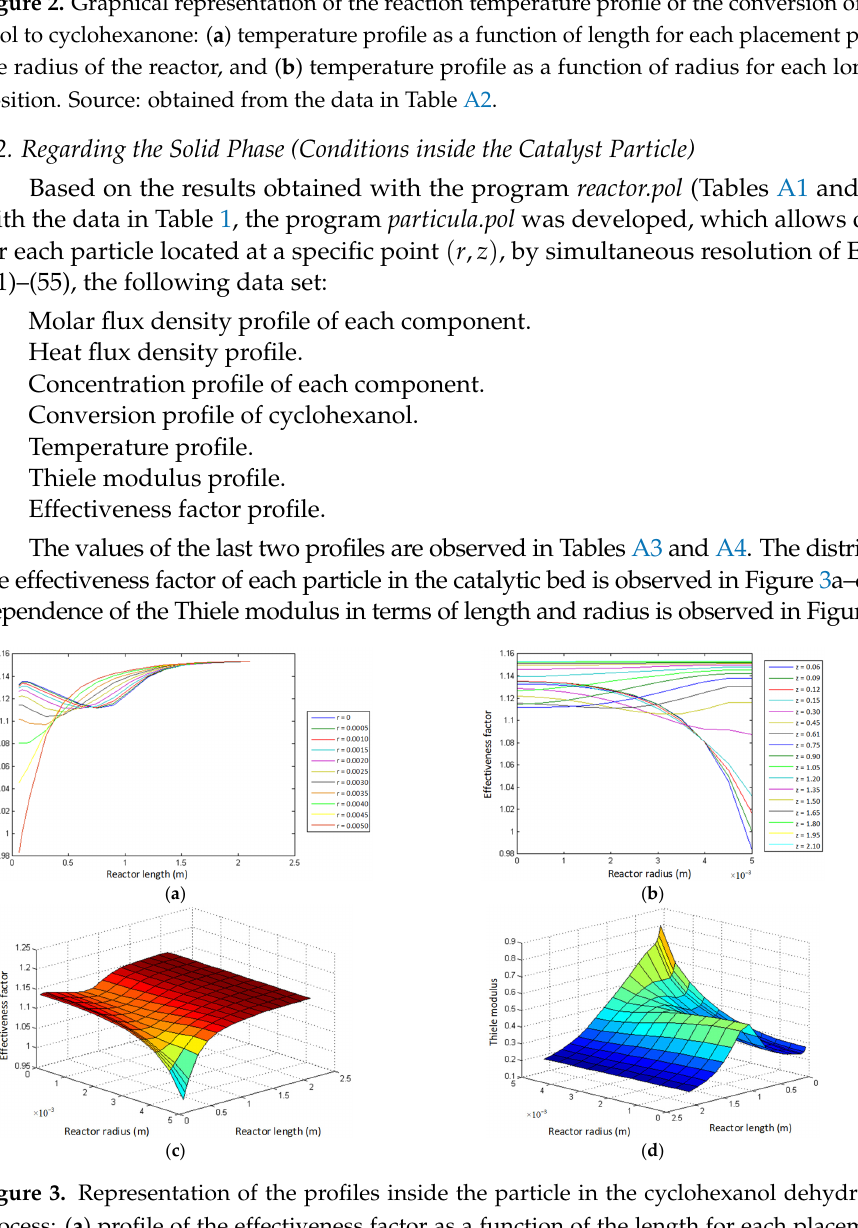
Figure 2. Graphical representation of the reaction temperature profile of the conversion of cyclohex- anol to cyclohexanone: ( a ) temperature profile as a function of length for each placement point along the radius of the reactor, and ( b ) temperature profile as a function of radius for each longitudinal position. Source: obtained from the data in Table A2.